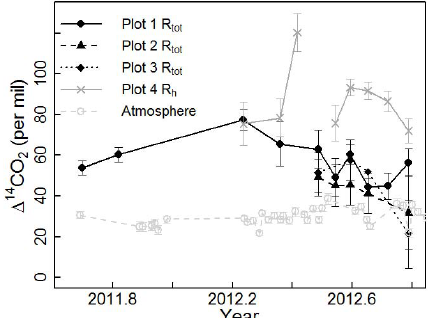
Fig. 3. Computed 1 14 CO 2 of surface flux ( R tot for intact plots and R h for trenched plot) and atmospheric 1 14 CO 2 (21m above ground level) for the same period. Note that for the trenched plot, fluxes on 2012.42 and 2012.49 were calculated using measurements from 14cm depth rather than 7cm, due to missing